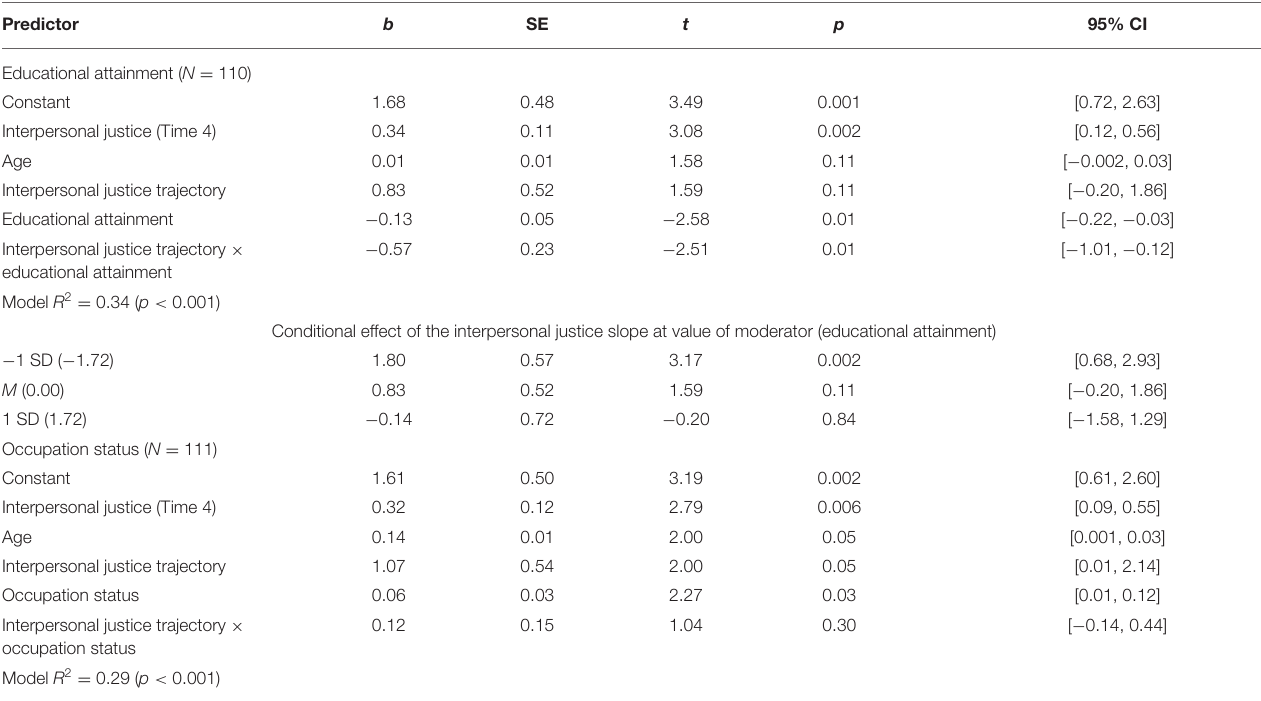
TABLE 5 | Results of interpersonal justice trajectory, objective social class, and interactions predicting perceptions of legitimacy. Predictor b